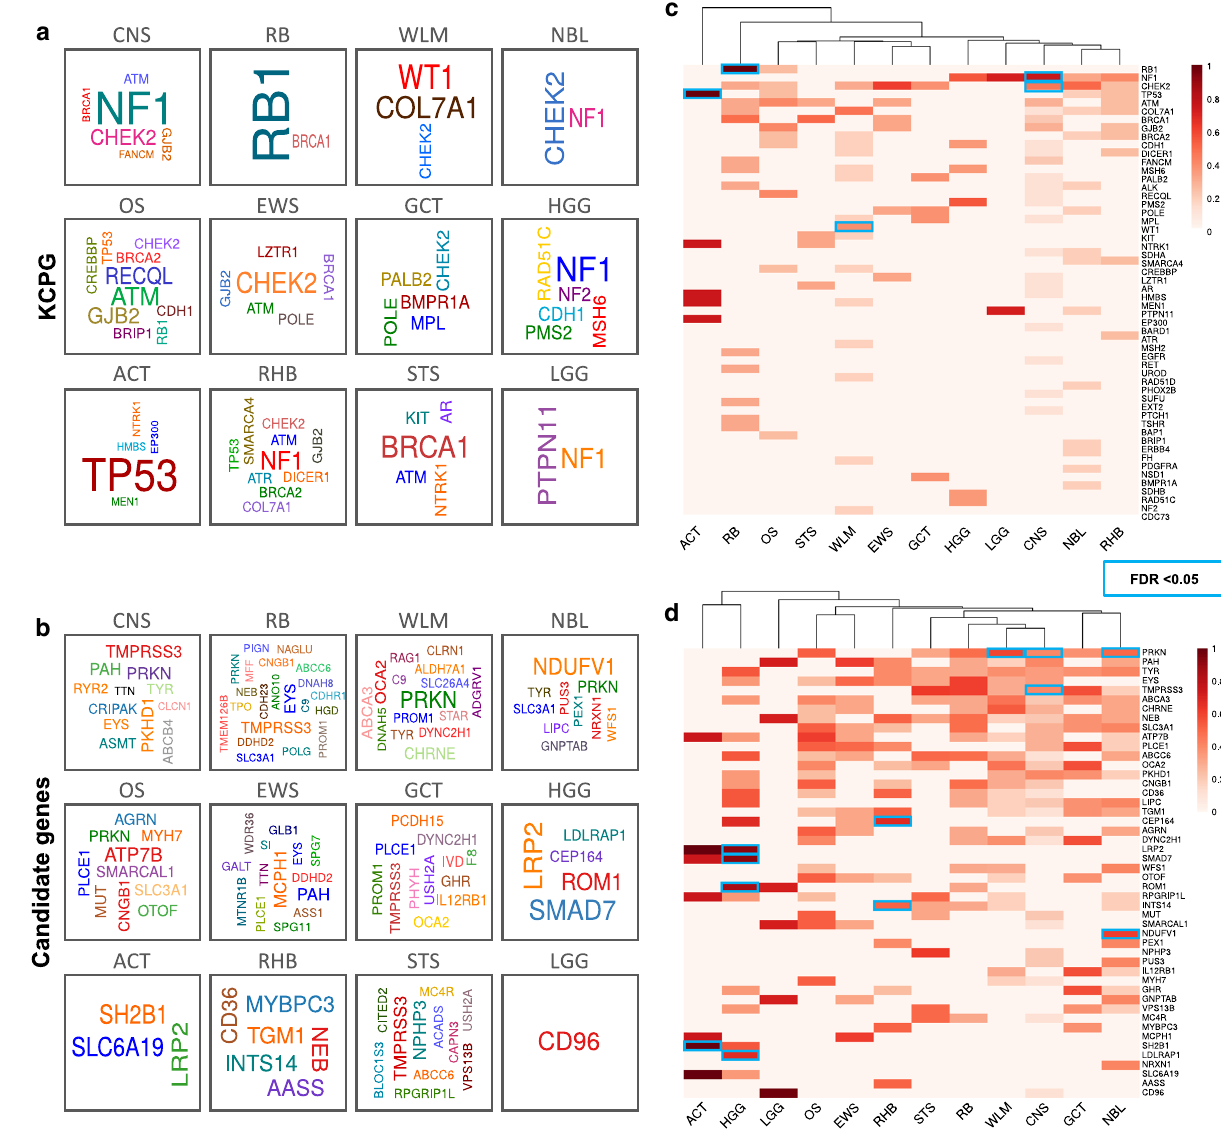
Fig. 3 Germline genomic signatures of children, adolescents, and young adults (C-AYA) with 12 types of solid tumors. a , b Germline gene cloud signatures of the C-AYA patients with solid tumors based on their altered known cancer-predisposing genes (KCPG) ( a ) or candidate genes ( b ). The size of the genes is proportional to their pathogenic/likely pathogenic (P/LP) variant frequency in that tumor type, colors do not specify any meaning. c , d Heat maps of top altered KCPGs ( c ) or candidate genes ( d ). Two-sided Fisher´s Exact test implemented in R statistical software. P values were adjusted for multiple testing with Bonferroni correction considering 593 tests. FDR threshold of 0.05 considered a signi fi cant event. Scale refers to log10 (frequency of P/LP variants in speci fi ed genes in each tumor type). Blue rectangles specify signi fi cant corrected P values in comparison to non-TCGA ExAC database. ACT adrenocortical carcinoma, CNS central nervous system, EWS Ewing sarcoma, GCT germ cell tumor, HGG high-grade glioma, LGG low-grade glioma, NBL neuroblastoma, OS osteosarcoma, RB retinoblastoma, RHB rhabdomyosarcoma, STS soft tissue sarcoma, WLM Wilms